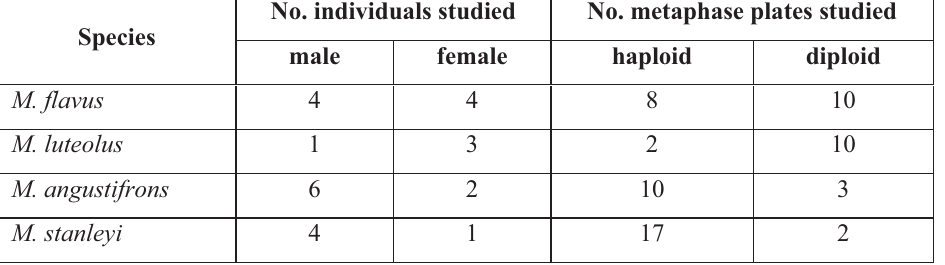
Table 1. Number of studied individuals and metaphase plates of Metaphycus species. No. individuals studied Species